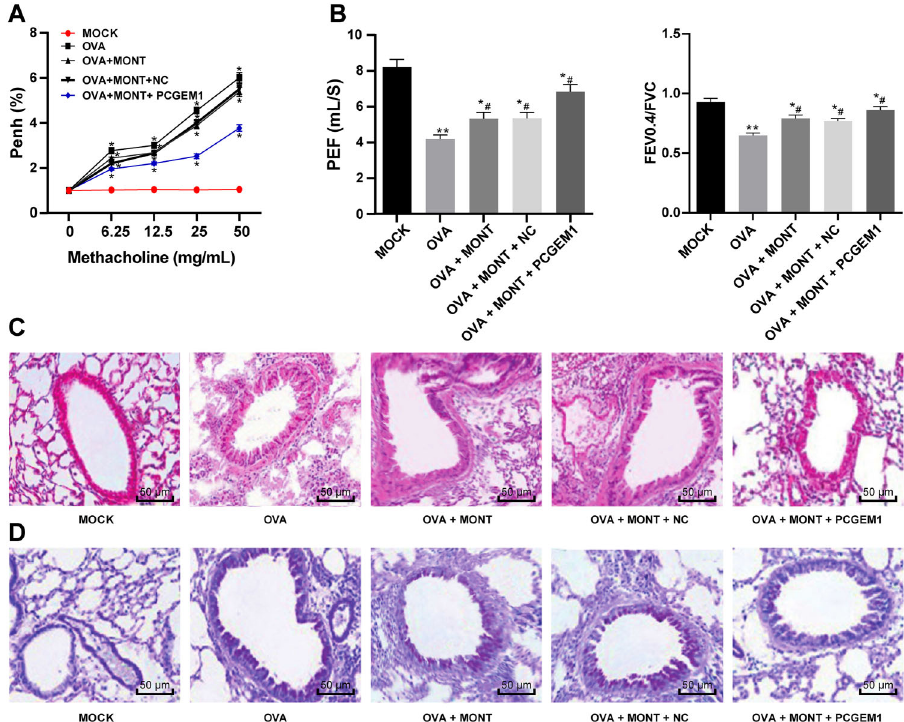
Figure 4. Upregulation of prostate cancer gene expression marker 1 (PCGEM1) strengthened the effects of montelukast sodium on pulmonary function in ovalbumin (OVA)-sensitized asthmatic mice treated with montelukast sodium (MONT) and PCGEM1 mimic, and normal control (MOCK). A , The airway hyperresponsiveness in the animals (n=6). B , Evaluation of peak expiratory fl ow (PEF) and forced expiratory volume in 0.4 s (FEV0.4) to forced vital capacity (FVC) ratio in the animals (n=6). C , HE staining showing in fl ammatory cell in fi ltration in lung tissue of the animals (n=3). D , PAS staining showing mucin secretion in airway goblet cells of the animals (n=3). Data are reported as means ± SD. *P o 0.05, **P o 0.001 vs the MOCK group; # P o 0.05 vs the OVA group. Data in panel A were analyzed by one-way ANOVA, followed by Tukey ’ s multiple comparisons post hoc test. Data in panel B were analyzed by two-way ANOVA, followed by Tukey ’ s multiple comparisons post hoc test. PENH(%): increased airway